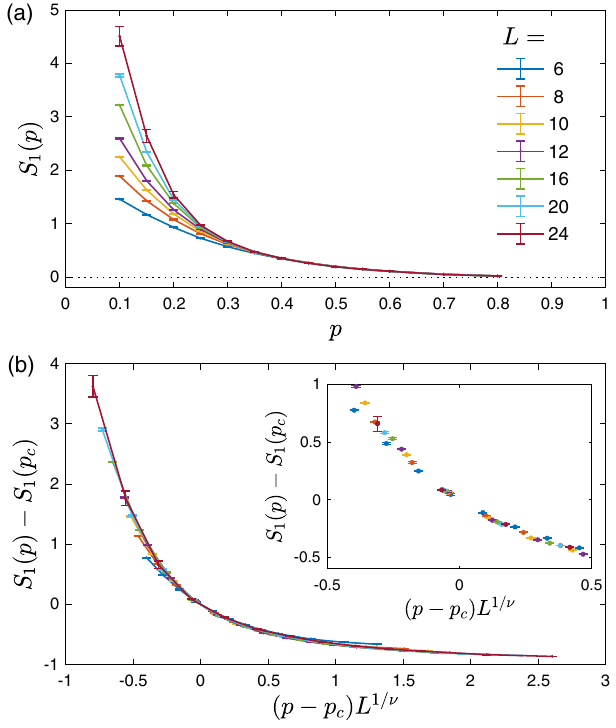
FIG. 13. Critical behavior of the von Neumann entanglement entropy S 1 for the random unitary circuit. (a) S 1 as a function of p for different values of the system size L , with t ¼ 2 L . (b) Critical scaling of these same data. The inset shows a zoomed-in view of the same data near the origin (with the solid lines